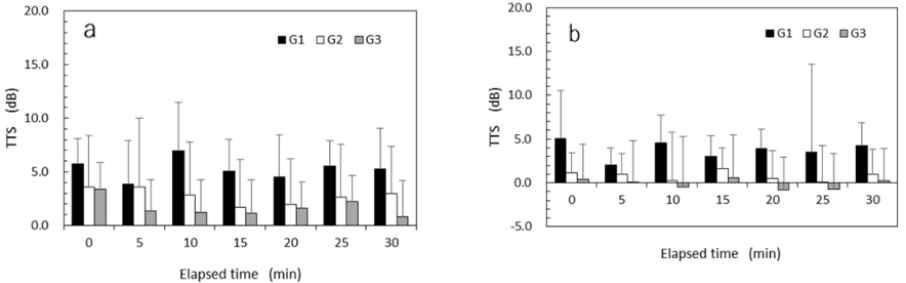
Figure 6. Temporary threshold shift (TTS) of vibrotactile perception at a test frequency of 31.5 Hz after exposure to high HAV ( a ) and low HAV ( b ). G1 denotes the exposed old group, G2 denotes the non-exposed old group, and G3 denotes the non-exposed young group. Table 5. ANOVA results of TTSs at a VPT test frequency of 31.5 Hz.